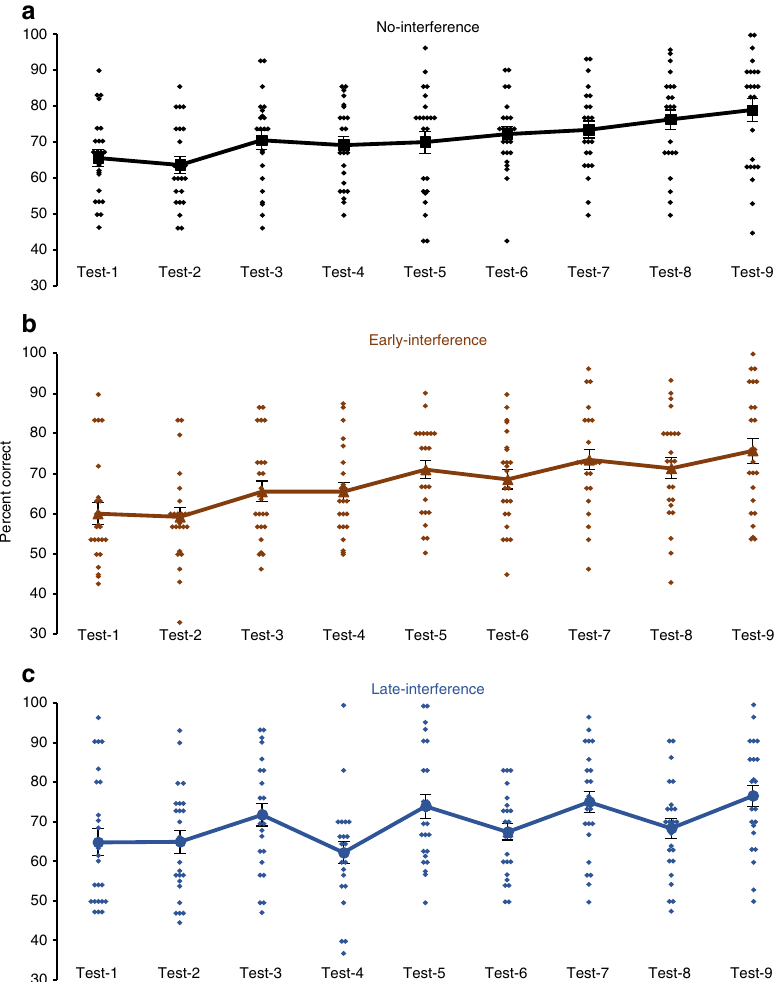
Fig. 4 Auditory classi fi cation performance in experiment-2. The mean percentage of trials responded to correctly in the nine posttests is shown for the a no-interference, b early-interference, and c late-interference conditions. Odd-numbered tests took place at 12:00 p.m., and even-numbered tests took place at 6:00 p.m. The same 24 starlings completed each condition. Error bars show standard error of the mean. Dot plots show individual scores for each test